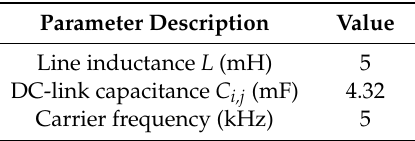
Table 1. CHB (Cascaded H-Bridge) inverter: simulation parameters.